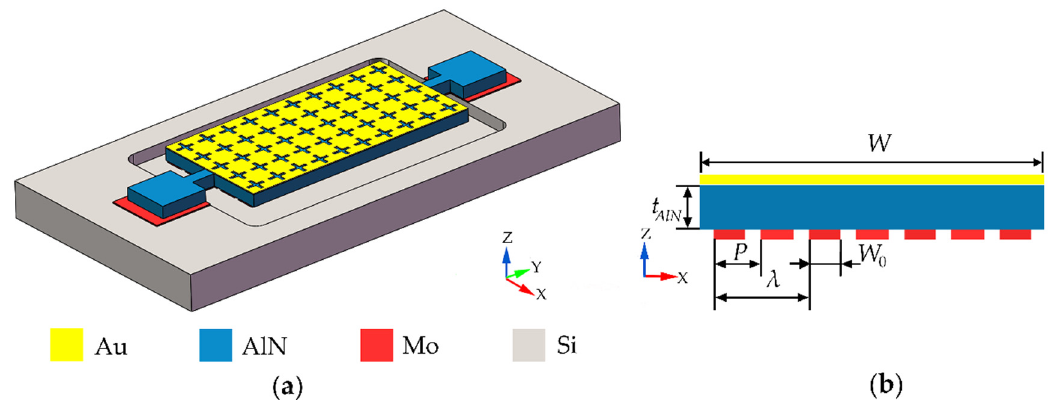
Figure 1. ( a ) Overview and ( b ) cross-section view of aluminum nitride (AlN) piezoelectric resonant infrared (IR) detector.